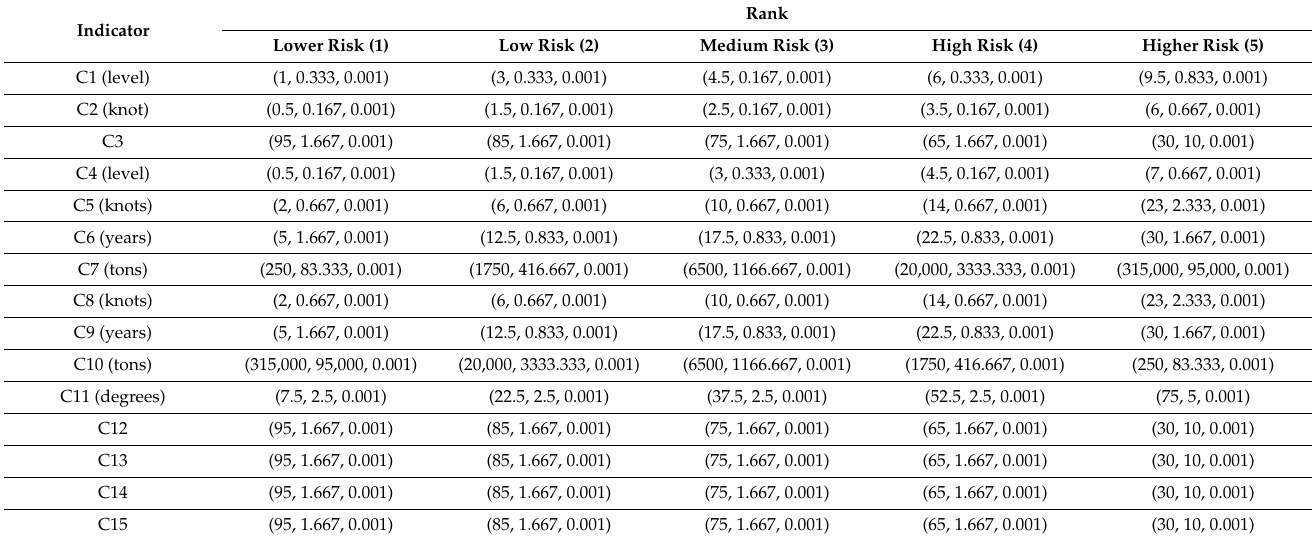
Table 2. The normal cloud models at all level of the emergency